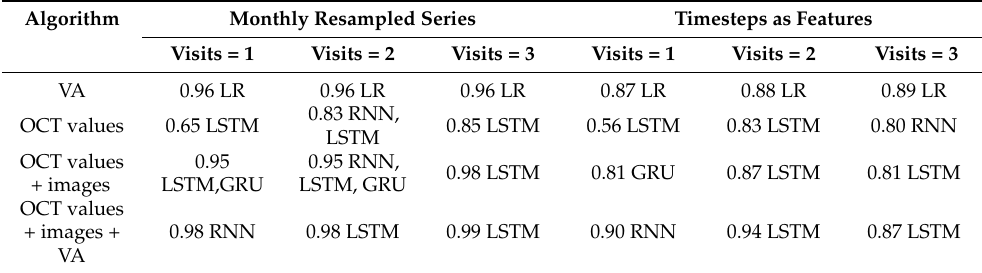
Table 13. Best forecasting results depending on the input